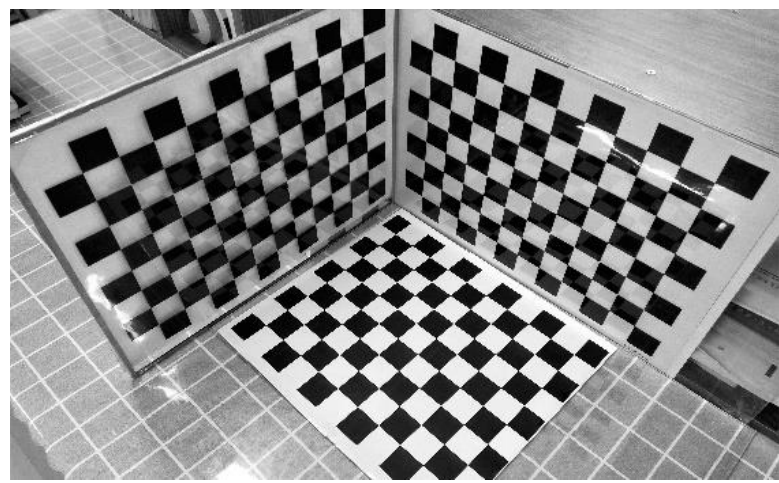
Figure 7. The sample trihedron used for the 3D reconstruction experiment.